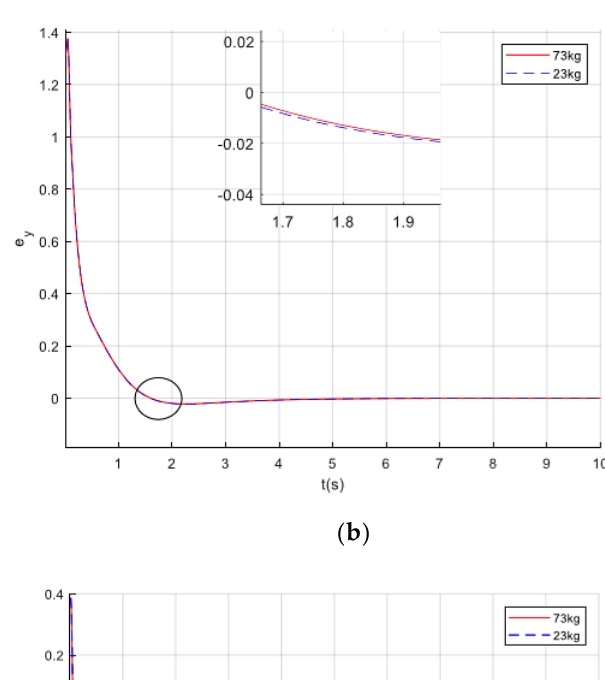
Figure 9. Result of linear errors e x ( a ), e y ( b ), and angular error e θ ( c ) in tracking linear trajectory under varying loads.